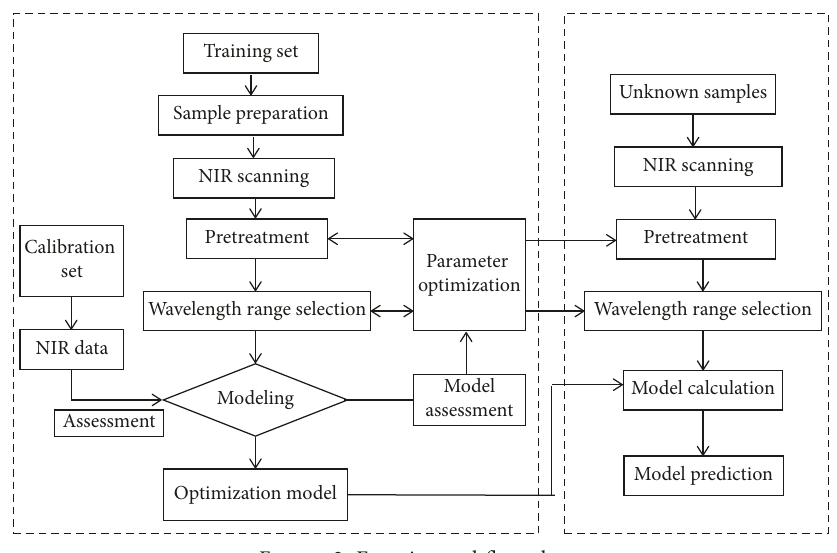
Figure 2: Experimental flow